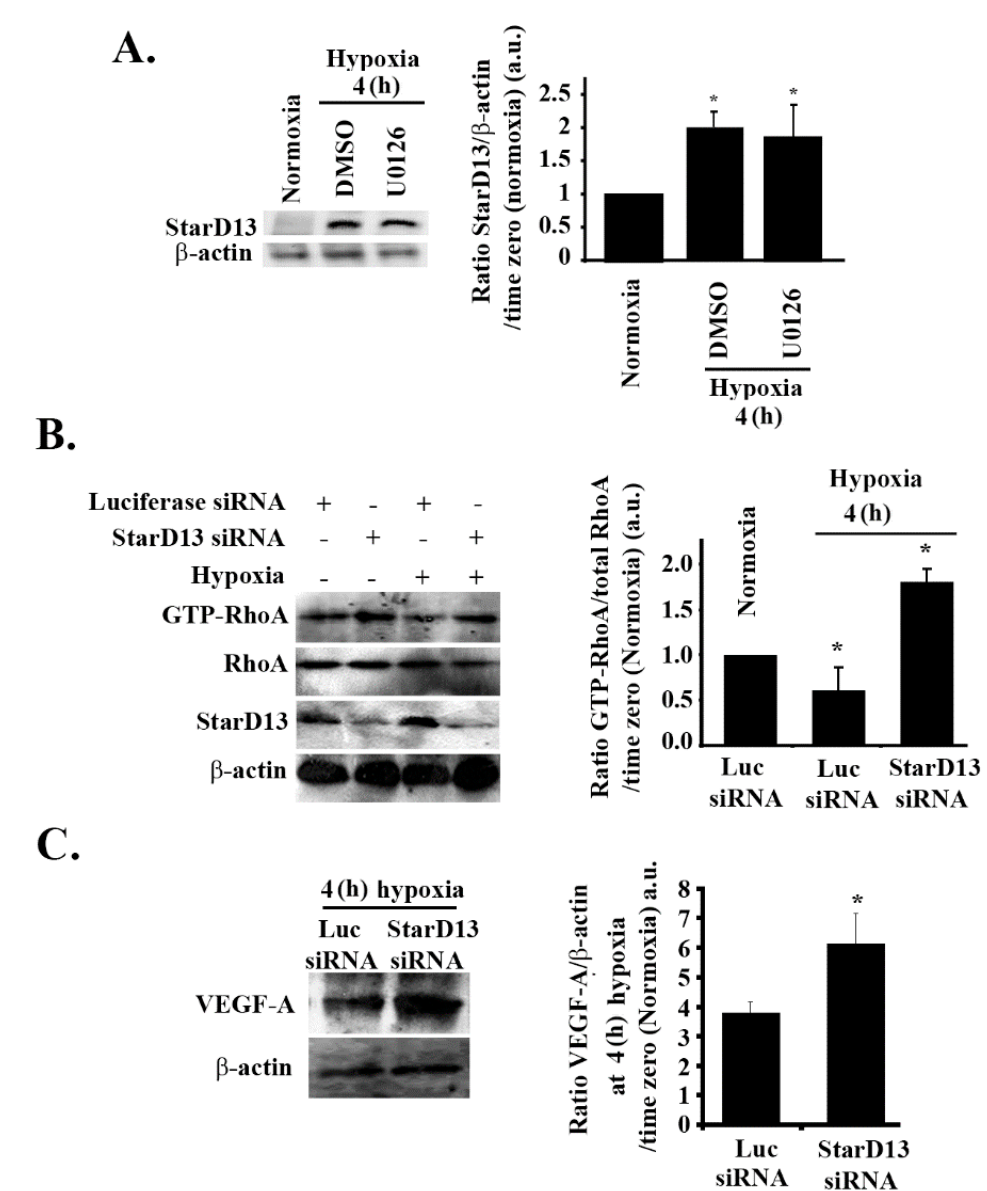
Figure 7. Hypoxia suppresses RhoA / C through StarD13. ( A ) SF-268 cells were treated with either DMSO or U0126 and subjected to hypoxia for 4 h or kept in normoxia. Cells were then lysed, and the lysates were blotted for StarD13 and β -actin for loading control. The graph is a densitometric analysis of the Western blots using Image J. Values are normalized to the loading control and expressed as fold change compared to time zero (normoxia). ( B ) ( + indicates addition of the treatment) SF-268 cells were transfected with either luciferase or StarD13 siRNA and subjected to hypoxia for 4 h, or left in normoxia and lysed. The lysates were then subjected to a RhoA pull-down assay, and the total lysates were blotted for anti-RhoA, anti-StarD13, and anti- β -actin. The graph is a quantitation of the bands in the upper gel normalized to total RhoA and expressed as fold change compared to control (luciferase siRNA / normoxia). ( C ) SF-268 cells transfected with luciferase or StarD13 siRNA and subjected to 4 h hypoxia. Cells were then lysed, and cell lysates were blotted for VEGF-A or β -actin. The graphs are quantitations of the VEGF bands normalized to actin and expressed as fold change compared to normoxia control. Values are expressed as fold change at every treatment to normoxia. The data are means ± SEM from three di ff erent experiments ( n = 3); * p < 0.05 indicates statistically significant di ff